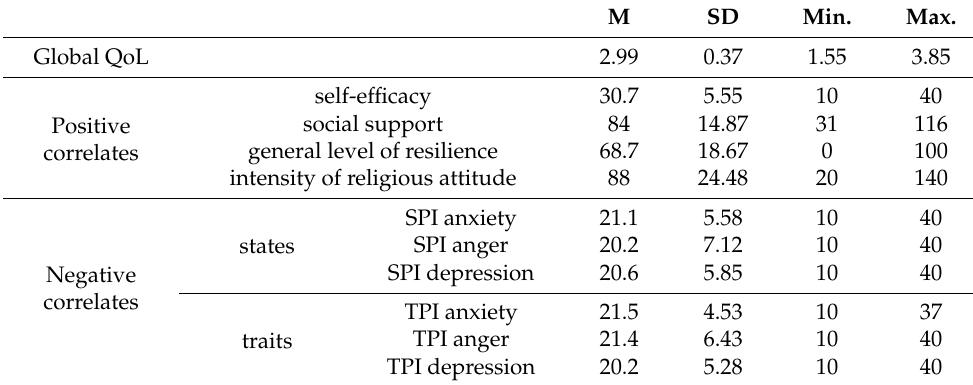
Table 1. Means and standard deviations for the study variables.